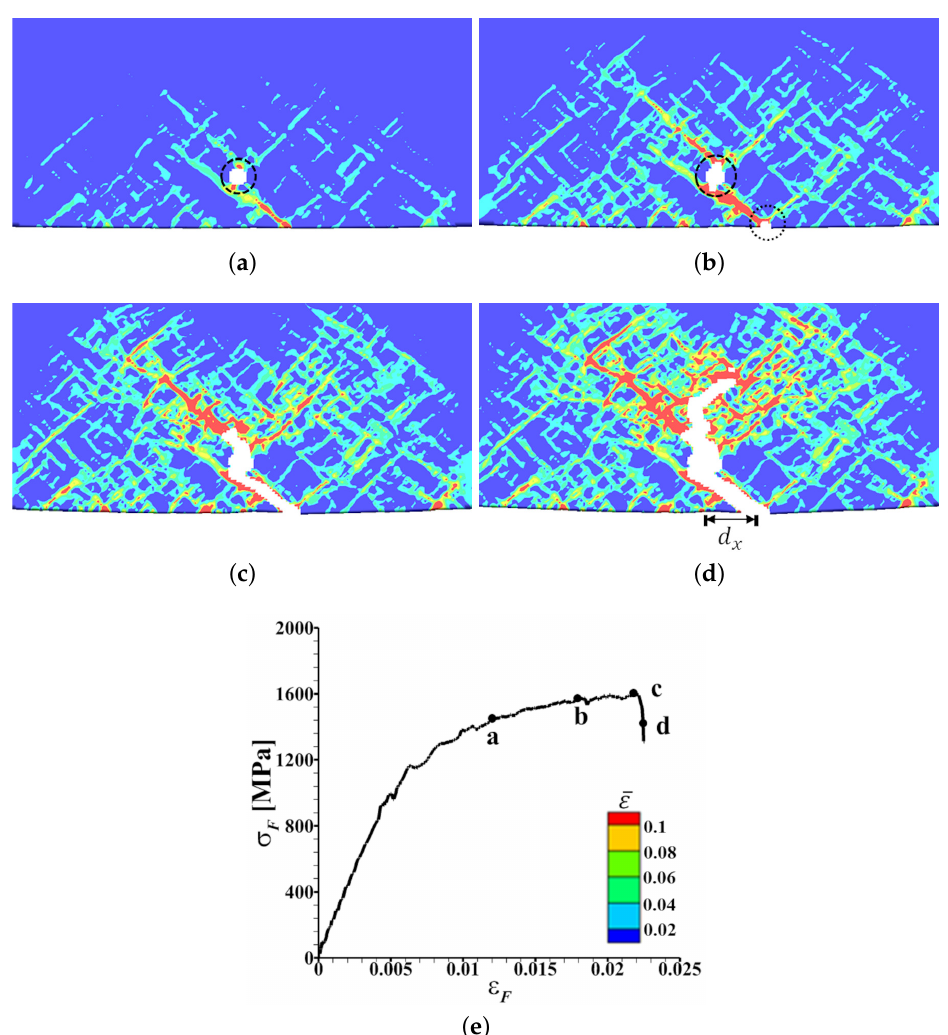
Figure 6. ( a – d ) The distribution of equivalent plastic strain, ¯ ε , in the near surface region on the tension side of a deformed 90 ◦ V-bend specimen with ‘discrete’ dual-phase microstructure and an inclusion of size, r I ≈ 3 e ( r I / r M ≈ 1.7), strength, ≈ 0.7) and location, dy / d = 0.125, at four macroscopic flexural strain, ε σ N = 300 MPa ( σ N / σ F 0 on the macroscopic flexural stress ( σ F )- ε F curve in ( e